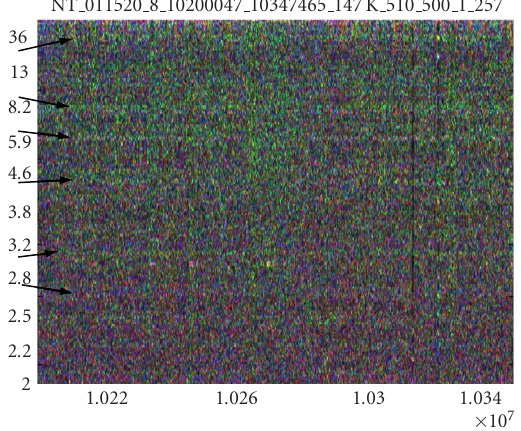
NT 011520 8 10200047 10347465 147K 510 500 1 257